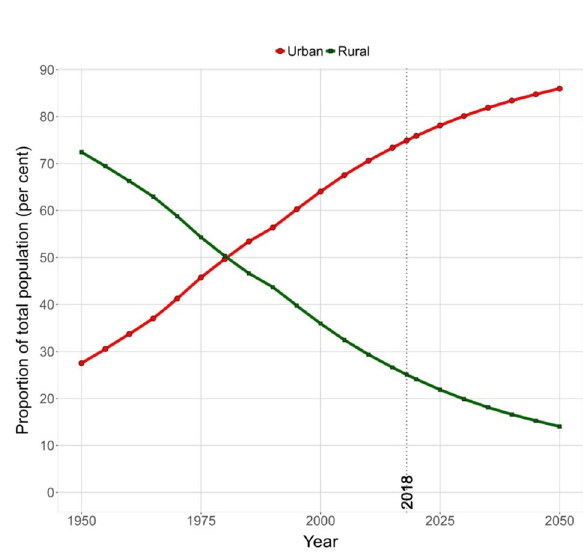
Fig. 3 Percentage of Iran ’ s urban and rural population in 1950 – 2050. According to the Human Development Report released by the United Nations, the urban population of Iran was 64.20% in 2000, rising to 75.94% in 2019 and is expected to rise to 85.82% in 2050 when the rural population will reach its nadir. The percentage of urban and rural populations in Iran from 1950 to 2050 is depicted in the fi gure. Since the 1980s; the urban pattern has replaced the rural pattern in Iran. For the fi rst time, the urbanization percent reached 51% in the 1986 of fi cial Census and this trend has continued to